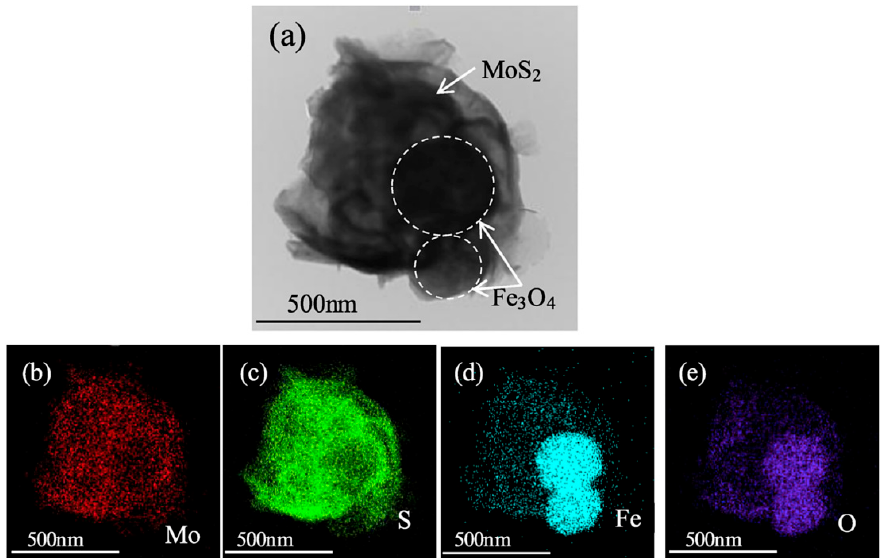
Figure 14. TEM ( a ) image and corresponding elemental mapping ( b – e ) images of Fe 3 O 4 @MoS 2 nanocomposites [87]. Reproduced with permission from [Yufu Xu et al.], [Tribology International]; published by [Elsevier], 2018.